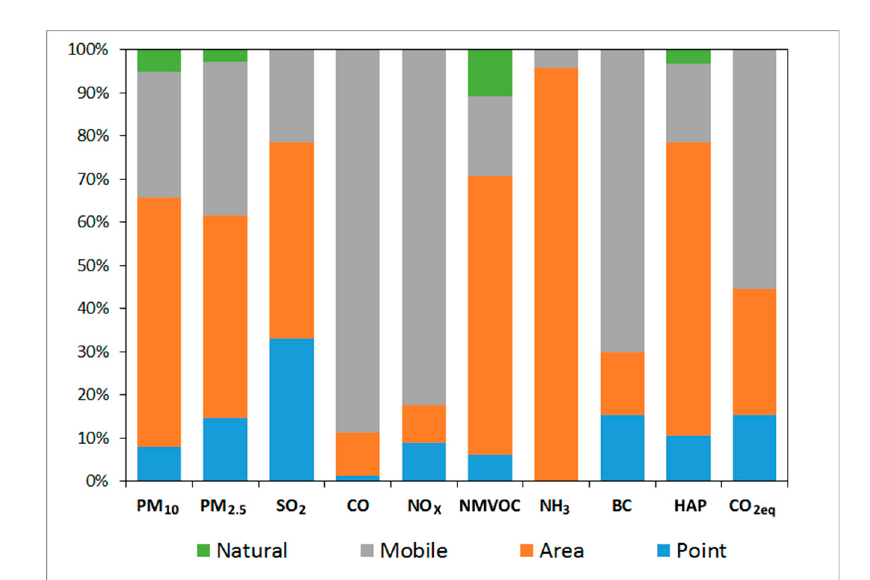
Figure 3. Contributions of emissions sources to the 2016 MCMA emissions inventory. HAP denotes hazardous air pollutants or air toxics. (Adapted from SEDEMA [25]).